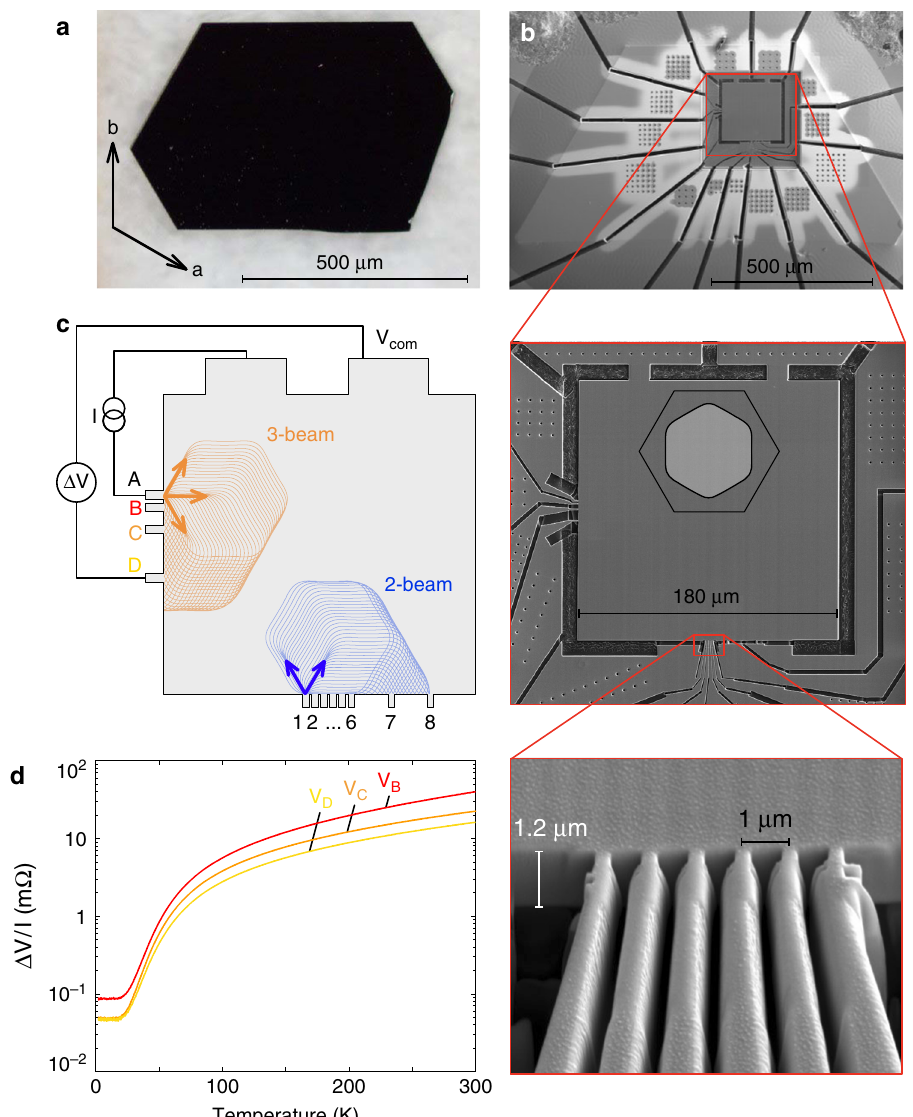
Fig. 2 Focused ion beam de fi ned TEF device, measurement scheme, and characterization. a Optical microscope image of a single crystal of PdCoO 2 with a thickness of ∼ 20 µ m. The crystal axes are rotated 90° away from the natural growth edges. b Top: scanning electron micrograph of a FIB-de fi ned TEF device. The crystal has been top-contacted with gold and structured into a multi-terminal transport device. Middle: magni fi cation of the central region. By top irradiation with a gallium ion beam, the crystal has been locally thinned down to ∼ 1 µ m. Two sets of nozzles, oriented 90° with respect to each other, probe TEF along the corner and the fl at sides of the hexagonal FS. Bottom: side view onto the lower set of nozzles, which are separated by 1 µ m and are ~250 nm wide. The long constrictions leading toward the nozzles act both as fl exures to reduce fractures and as collimators. c Experimental setup for probing directional-dependent TEF. In all measurements, the current is sourced between the top-left large electrode and a nozzle, and the voltage is measured between the top-right electrode (V com ) and a second nozzle. d Nonlocal voltage signal divided by the sourced current as a function of temperature. The measured voltages are in good agreement with the solutions to the Laplace equation solved with fi nite-element simulations by assuming in-plane resistivities of ρ 300K = 3 µ Ω cm and ρ 2K = 8 n Ω